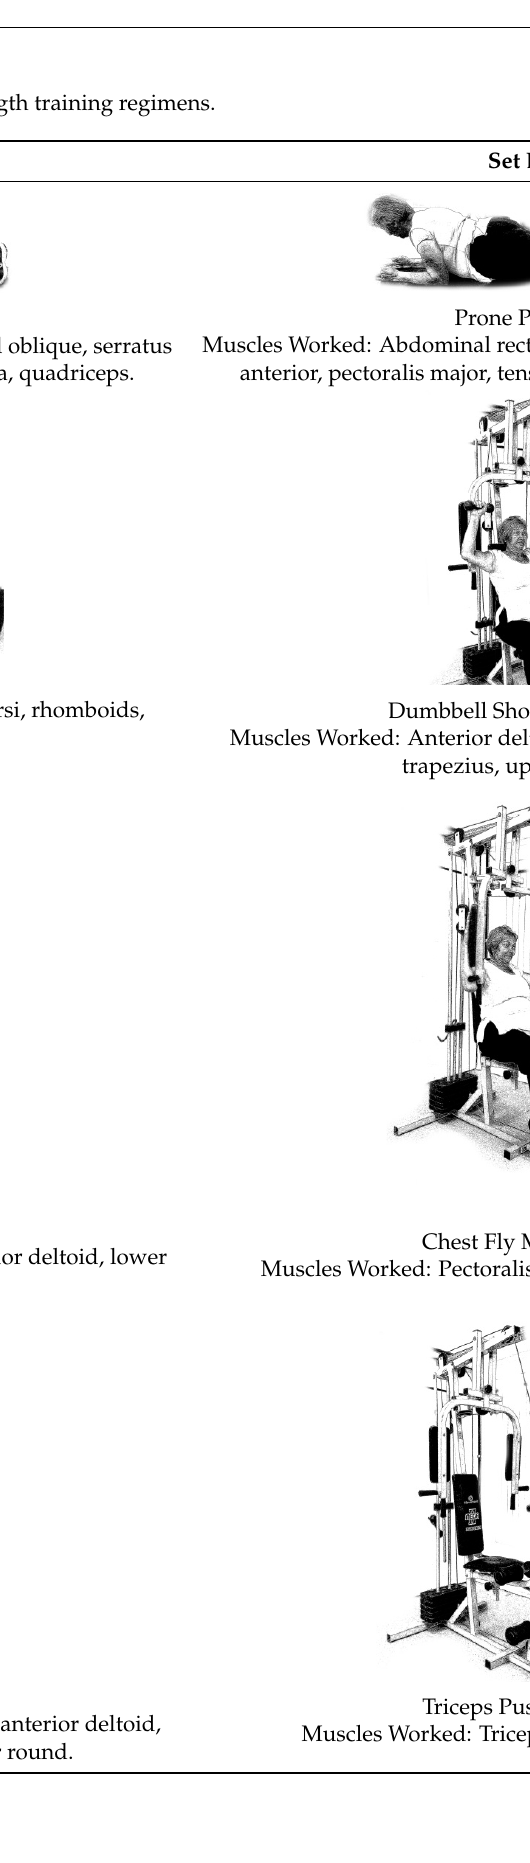
Table 1. Strength training regimens.